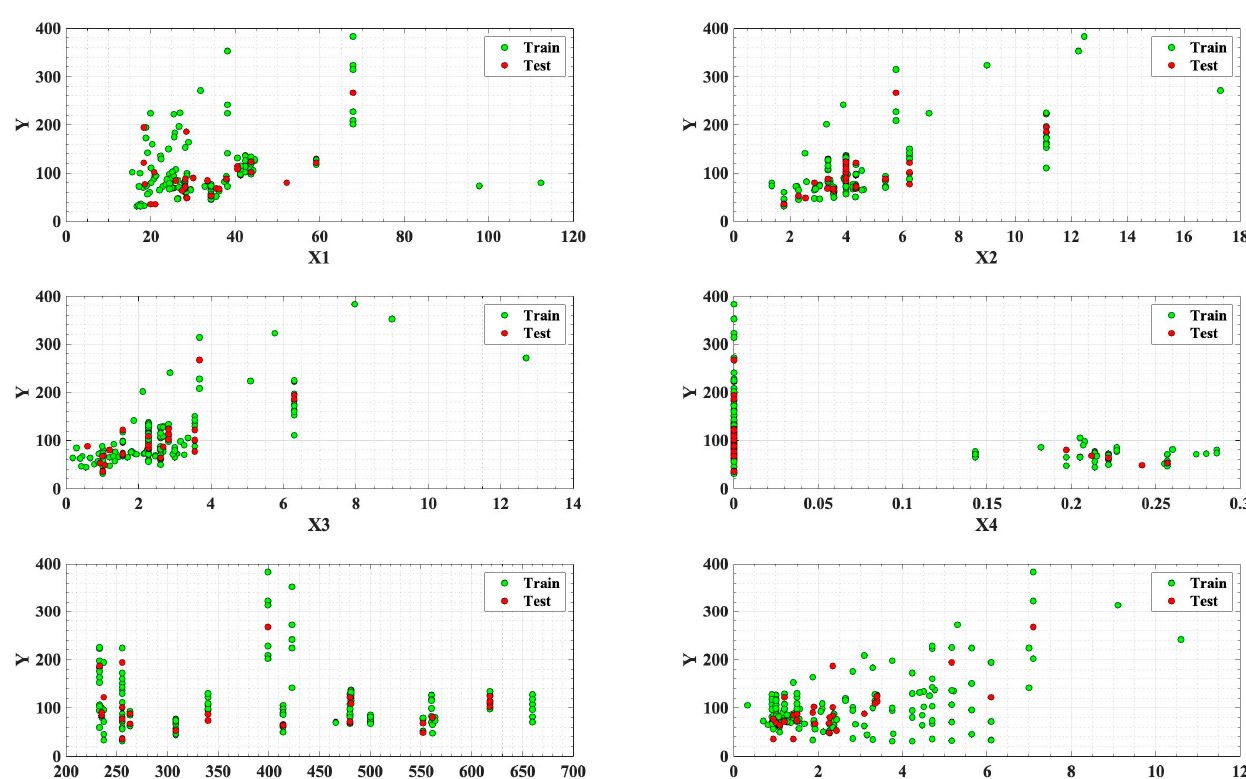
Figure 5. The distribution of the training and testing datasets.